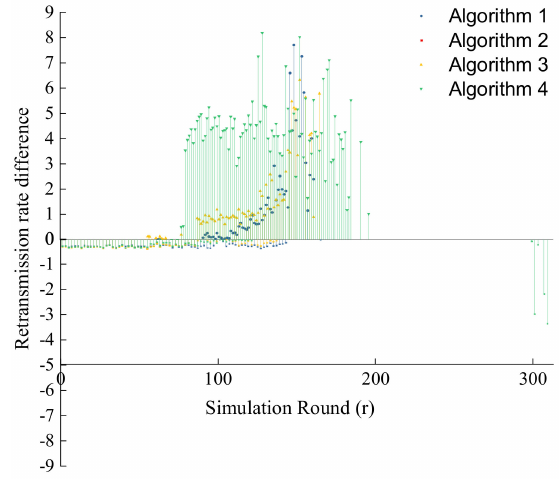
Figure 9. Retransmission rate difference.